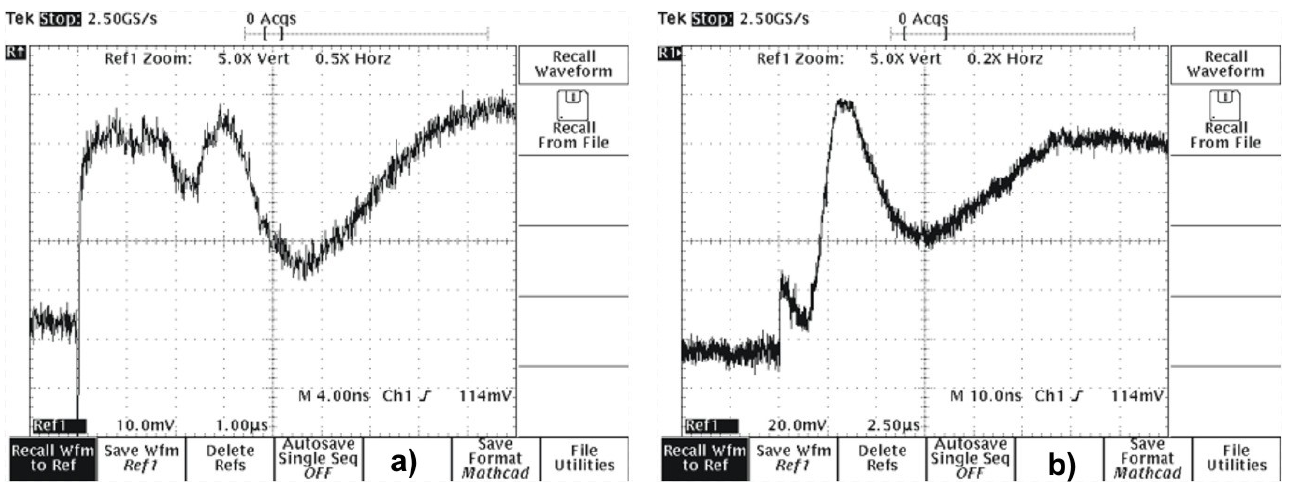
Figure 23. Oscillograms of shock-wave generated in stone samples by intense pulse laser irradiation: a) fluence 2.5 J/cm 2 ; b) fluence 4.5 J/cm 2